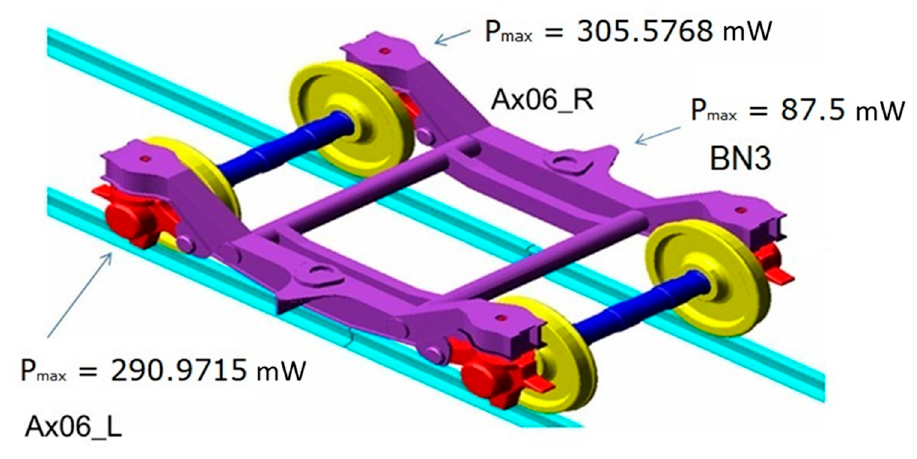
Figure 15. The estimated maximum generated power from the vertical vibration of the axles and bogie when the total damping ratio ξ T is 0.001, the mass is 0.1 kg, and the natural frequencies are 50.3 Hz (axle) and 45.9 Hz (bogie).